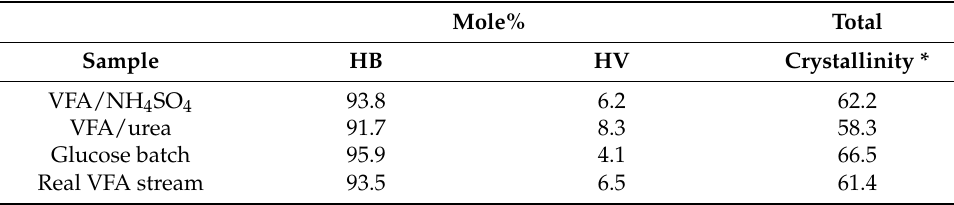
Table 3. Composition of the copolymers and the total crystallinity found.